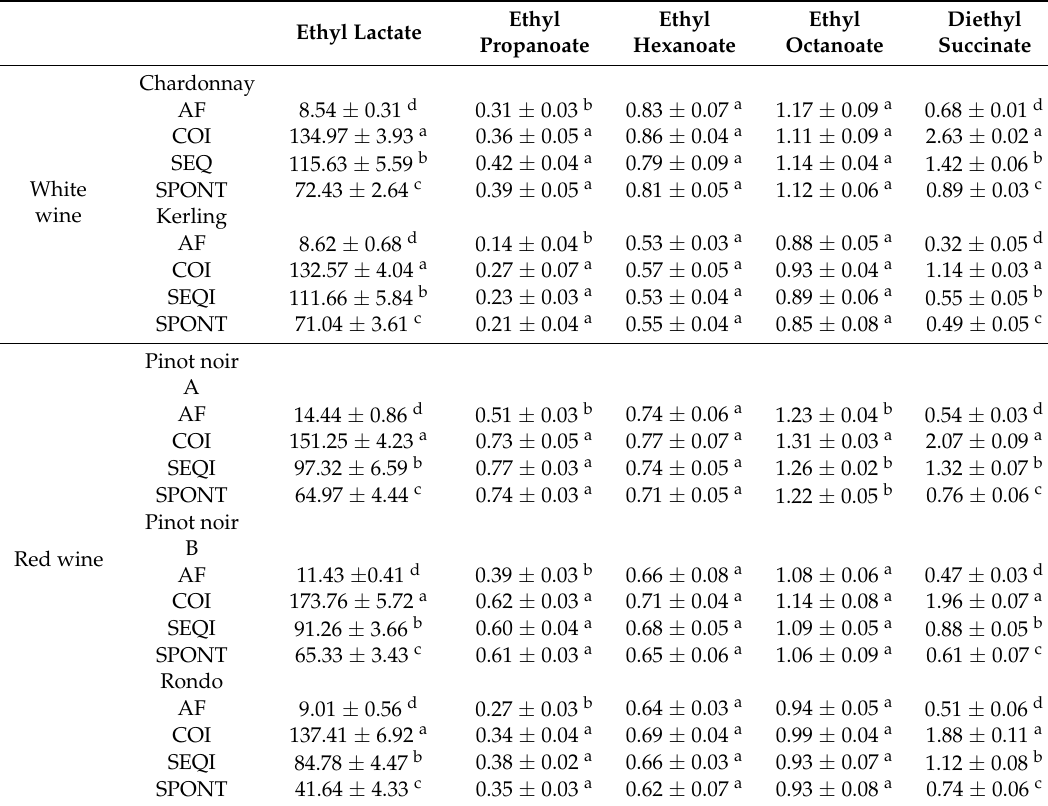
Table 2. Concentrations (mg/L) of esters in white and red grape wines produced by different methods of MLF induction; parameters were evaluated three months after bottling Ethyl Ethyl Ethyl Ethyl Lactate Propanoate Hexanoate